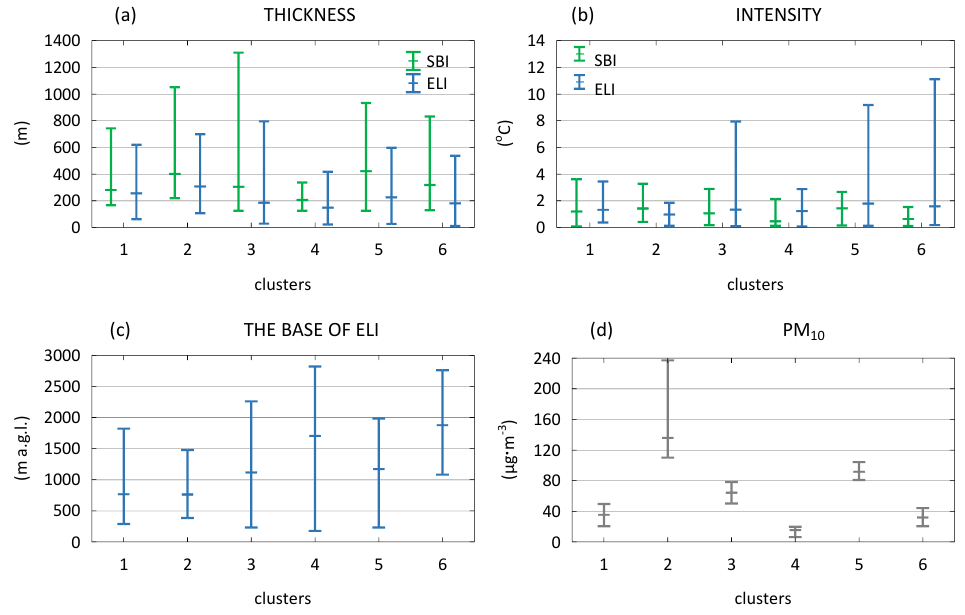
Figure 7. Basic characteristics (mean and min-max) of TI layers ( a – c ) and PM 10 ( d ) in selected clusters. Air quality in distinct clusters: 1—good, 2—very bad and bad, 3—moderate, 4—very good, 5—su ffi cient,